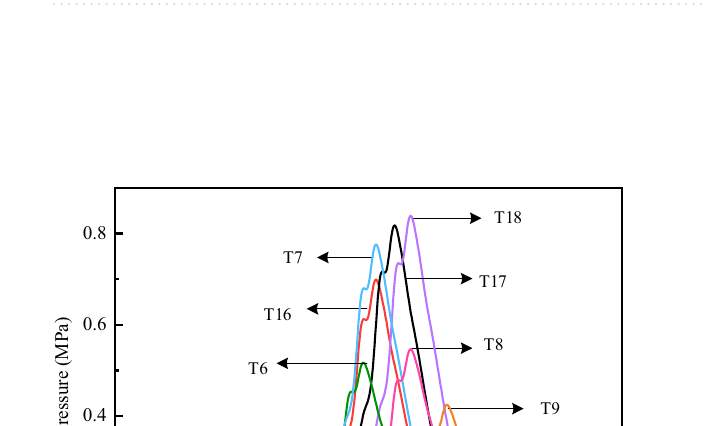
Figure 4. Maximum explosion overpressure for a 20% hydrogen volume fraction. ( a ) O–A–B–C branch; ( b ) O–A–D–F–H–G branch; ( c ) O–A–B–E–H–G branch; ( d ) O–A–D–E–H–G branch.